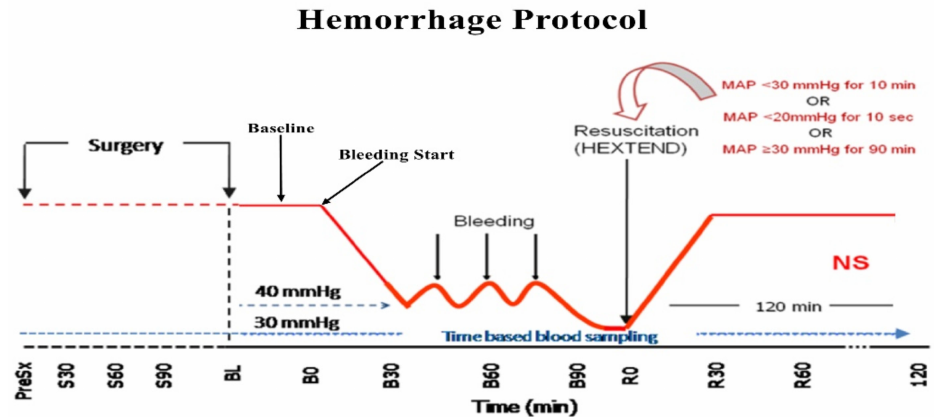
Figure 1. Schematic representation of the hemorrhagic shock protocol. Cited and modified from [19,20] with permission from